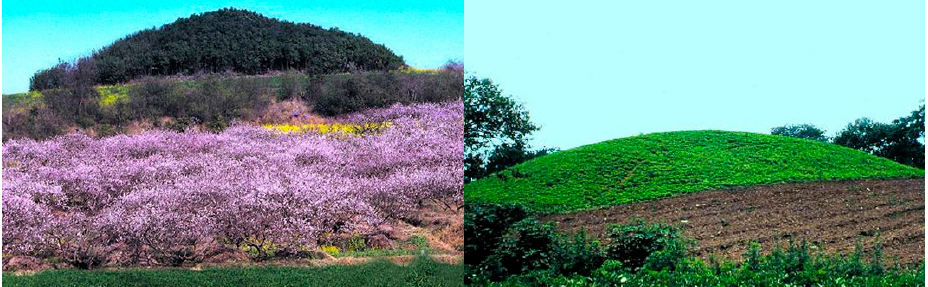
Figure 2. Tombs under dense vegetation.